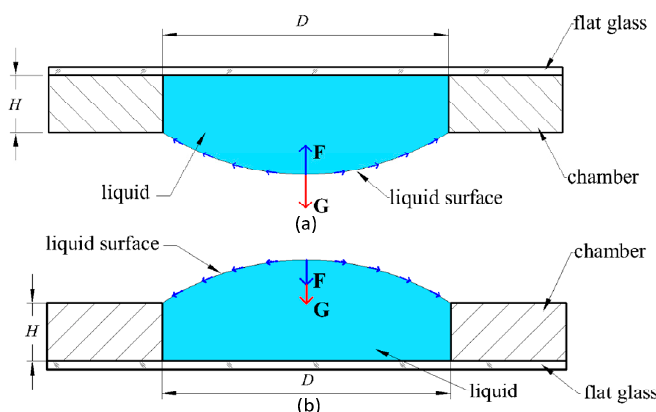
Figure 2. The force and deformation of the LFL. ( a ) inverted state, ( b ) positive state. D is the aperture of the chamber. H is the thickness of the chamber.